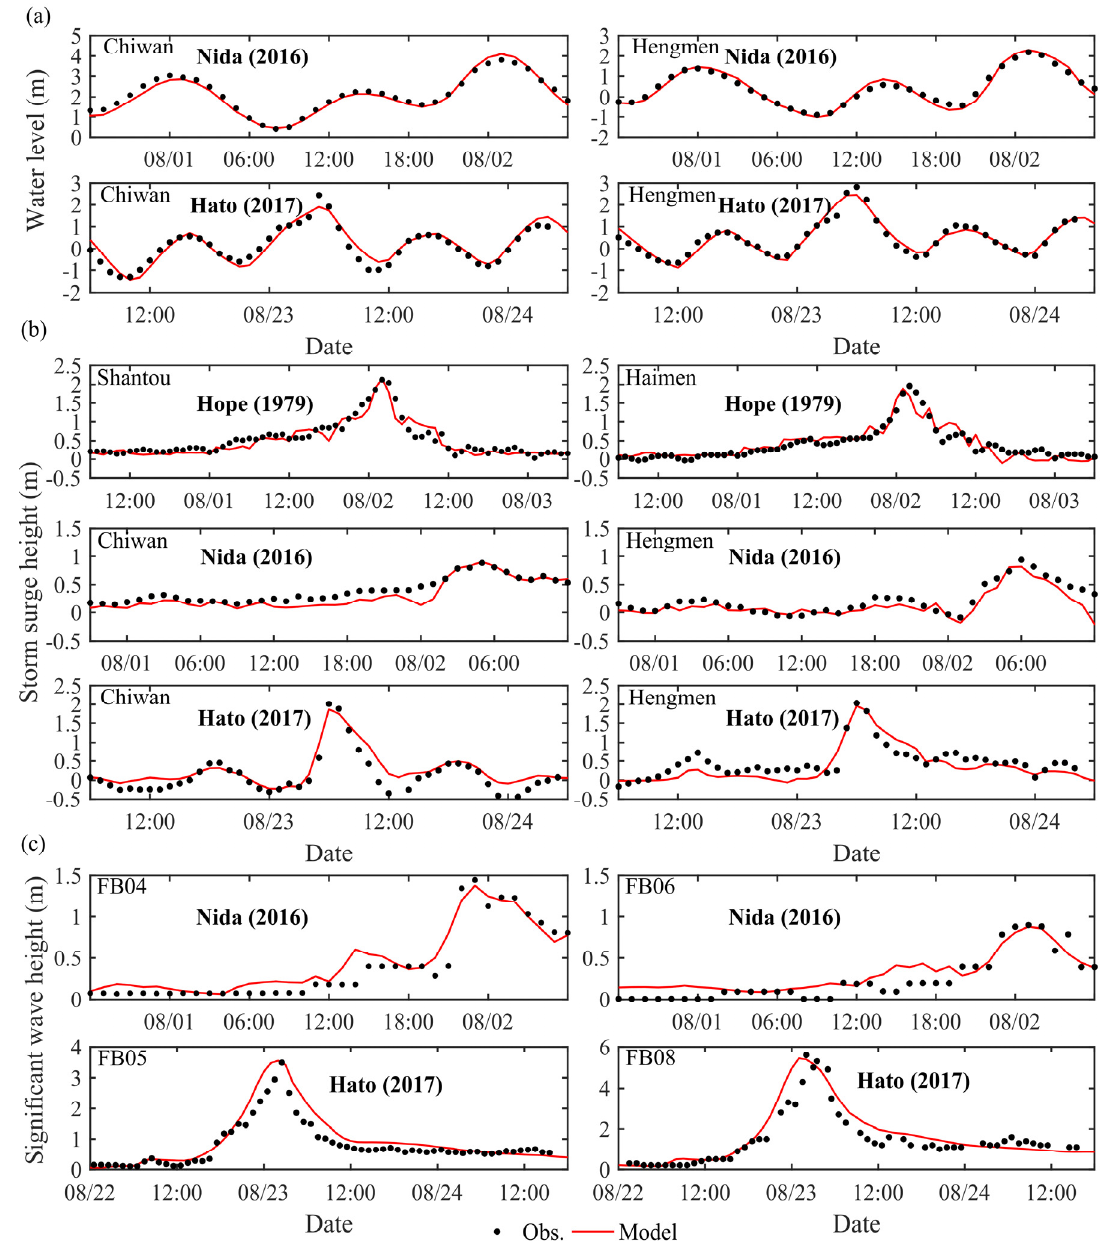
Figure 5. Comparisons between simulations and observations for the temporal variation of water levels ( a ; units: m), storm surge heights ( b ; units: m), and significant wave heights ( c ; units: m). Locations and names of meteorological gauges and buoys are marked in Figure 4b. The black “.” shows the observation data and the red “–” shows the result of the model.